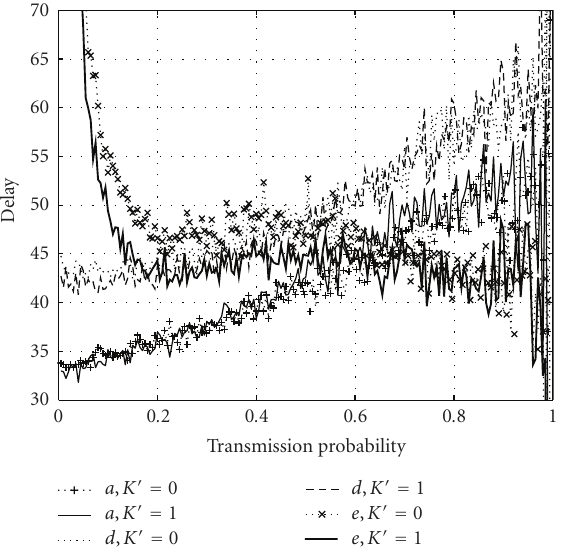
Figure 16: Delay of the dynamic ( K (cid:5) = 1) and static ( K (cid:5) = 0) cases for K = 4 (connections a , d , and e of the asymmetric network of Figure